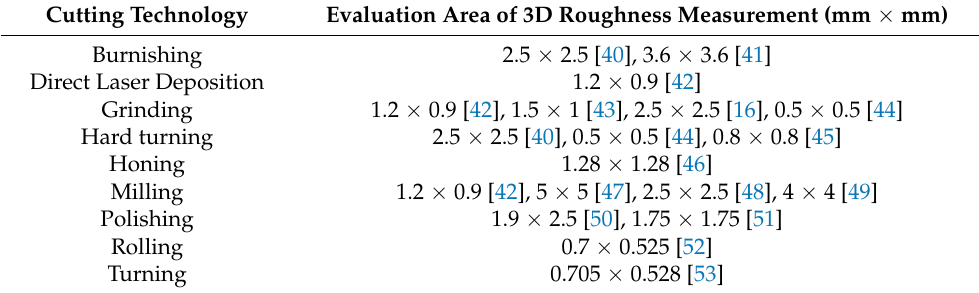
Table A1. Applied roughness evaluation areas in various cutting technologies.